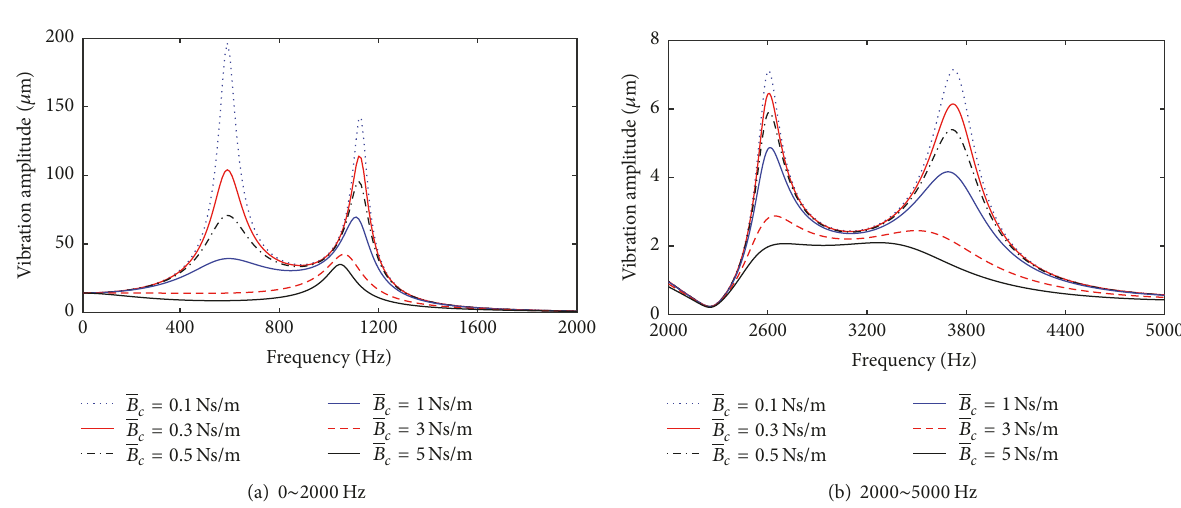
Figure 13: Influence of viscous damping coefficient 𝐵 𝑐 on harmonic